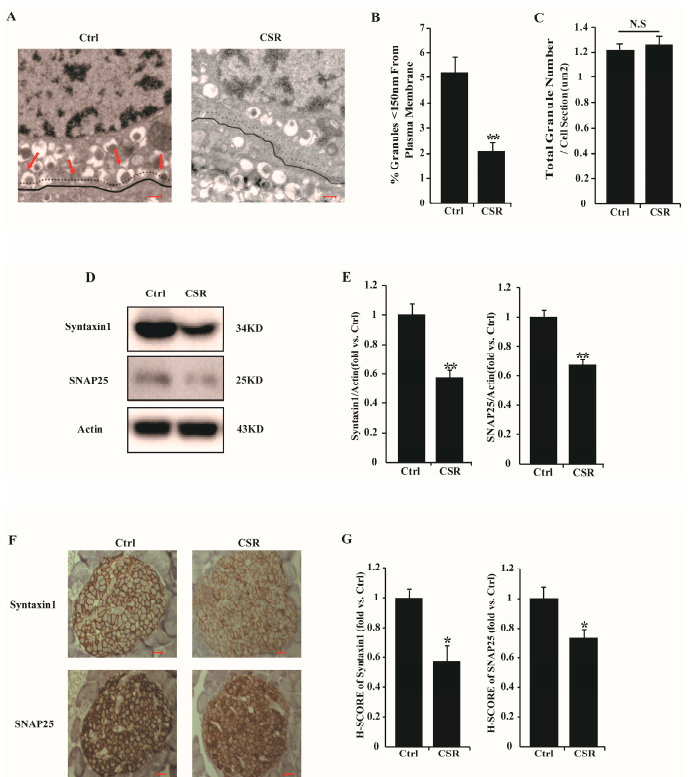
Figure 6. Chronic sleep restriction reduced insulin granules docking at pancreatic β cell membrane: ( A ) Representative electron micrographs of control and CSR rats pancreatic β cells were shown. Pancreatic β cell membrane and 150 nm distance from plasma membrane were traced in black solid line and dashed line, respectively. Arrowheads point to examples of docked granules, scale bar = 300 nm.; ( B ) The percentage of insulin granules localized to the plasma membrane (<150 nm) within β cells; ( C ) Average total insulin granule number was calculated, normalized to cell section; ( D ) Protein levels of Syntaxin1 and SNAP25 in islets; ( E ) Quantification of ( D ); ( F ) IHC staining of Syntaxin1 and SNAP25 in islets, scale bar = 10 µm; ( G ) Quantification of ( F ).* p < 0.05, ** p < 0.01 vs. control. N.S = no significant change. n = 5.